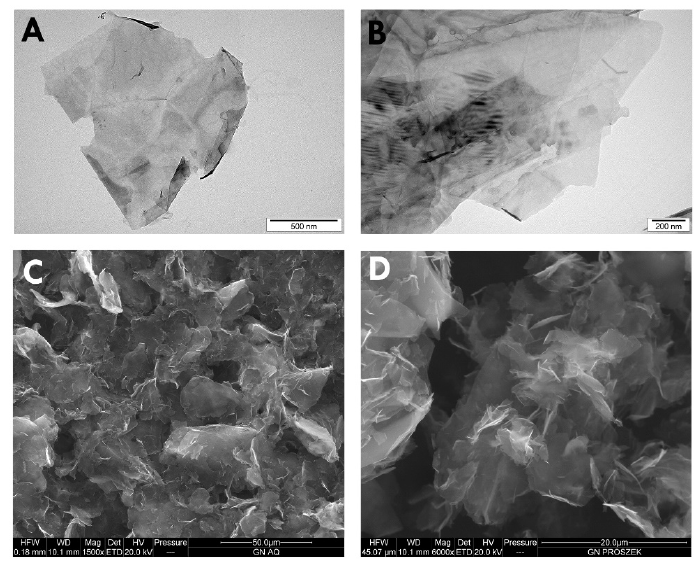
Figure 1. Characterization of pristine graphene by transmission electron microscopy ( A , B ) and scanning electron microscopy ( C , D ).